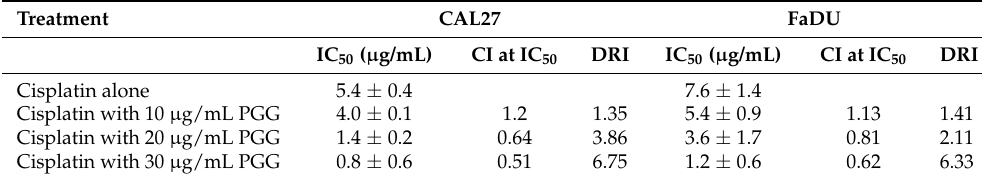
Table 1. Summary of cisplatin IC 50 ( µ g/mL), combination index (CI) values, and dose reduction index (DRI) of PGG and cisplatin combination treatment in HNSCC